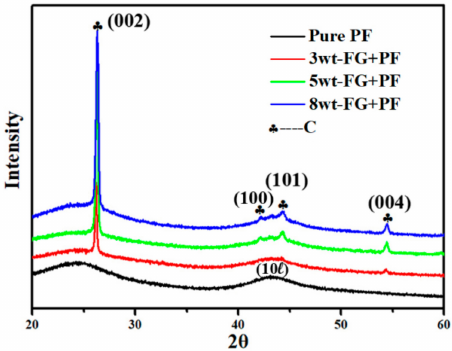
Figure 6. XRD patterns of products from pyrolysis of GNPs / phenol–formaldehyde (PF) mixture at 1000 ◦ C with di ff erent FG contents exfoliated 16 times.